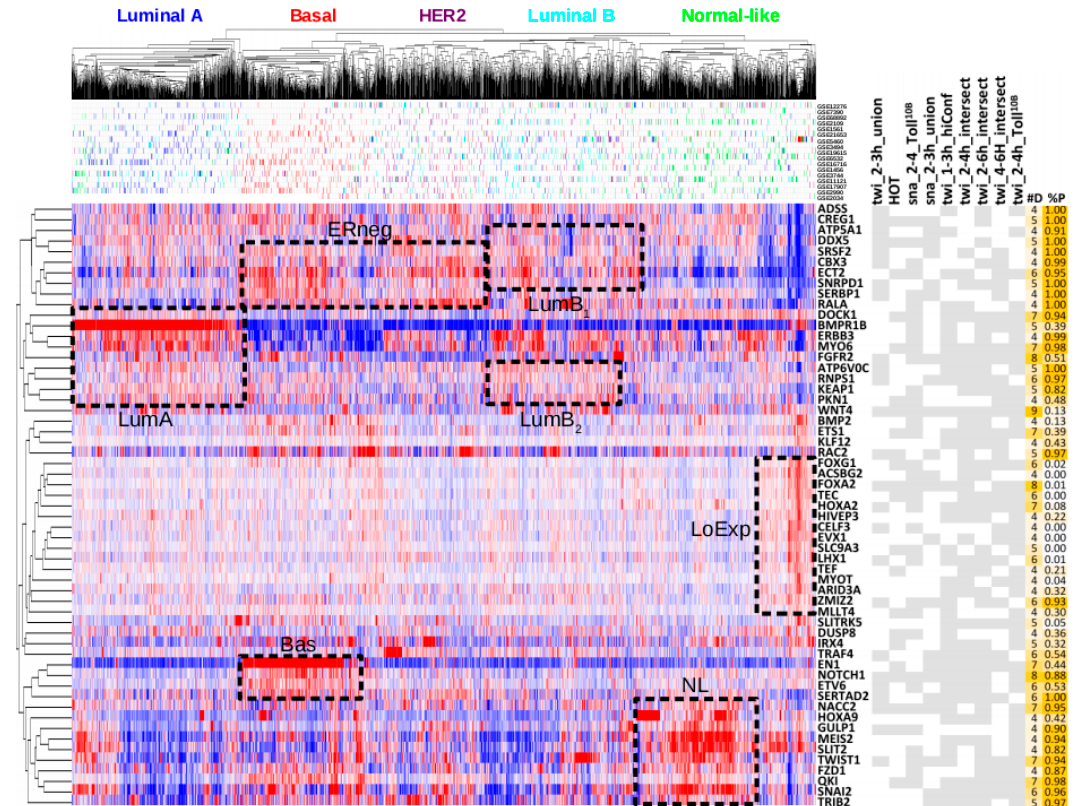
Figure 5. Predicted functional transcription factor targets capture human breast cancer biology. The heatmap shows gene expression in 2999 primary breast tumours for ORTHO-57 genes (red = high, white = mean, blue = low). The mosaic above the heatmap indicates intrinsic molecular subtype: Luminal A (blue), basal-like (red), HER2-overexpressing (purple), luminal B (light blue), and normal-like (green). Annotated heatmap features (black dashed lines) identified genes upregulated in one or more intrinsic subtype; “Bas” (basal-like), “NL”(normal-like), “ERneg” (basal-like and HER2-overexpressing), “LumB 1 ”(luminal B), “LumB 2 ”(luminal B), “LumA” (luminal A), and “LoExp” (low expression). The table to the right of the heatmap indicates inclusion (grey) or absence (white) across TF_ALL; the number of datasets where the gene was identified by NetNC-FTI (#D) and the percentage of present calls across the 2999 tumours (% p ) are shown. The LoExp feature corresponded overwhelmingly to genes with low % p values and to samples from a single study [121]. Some genes were annotated to more than one feature and reciprocal patterns of gene expression were found. For example, BMPR1B , ERBB3 , and MYO6 were strongly upregulated in feature LumA but downregulated in basal-like and HER2 -overexpressing cancers. Unexpectedly, feature NL (normal-like) had high expression of canonical EMT drivers, including SNAI2 , TWIST, and QKI . Some of the EMT genes in feature NL were upregulated in many basal-like tumours, while genes in feature Bas ( NOTCH , SERTAD2 ) had relatively high expression in normal-like tumours. Also see Figure